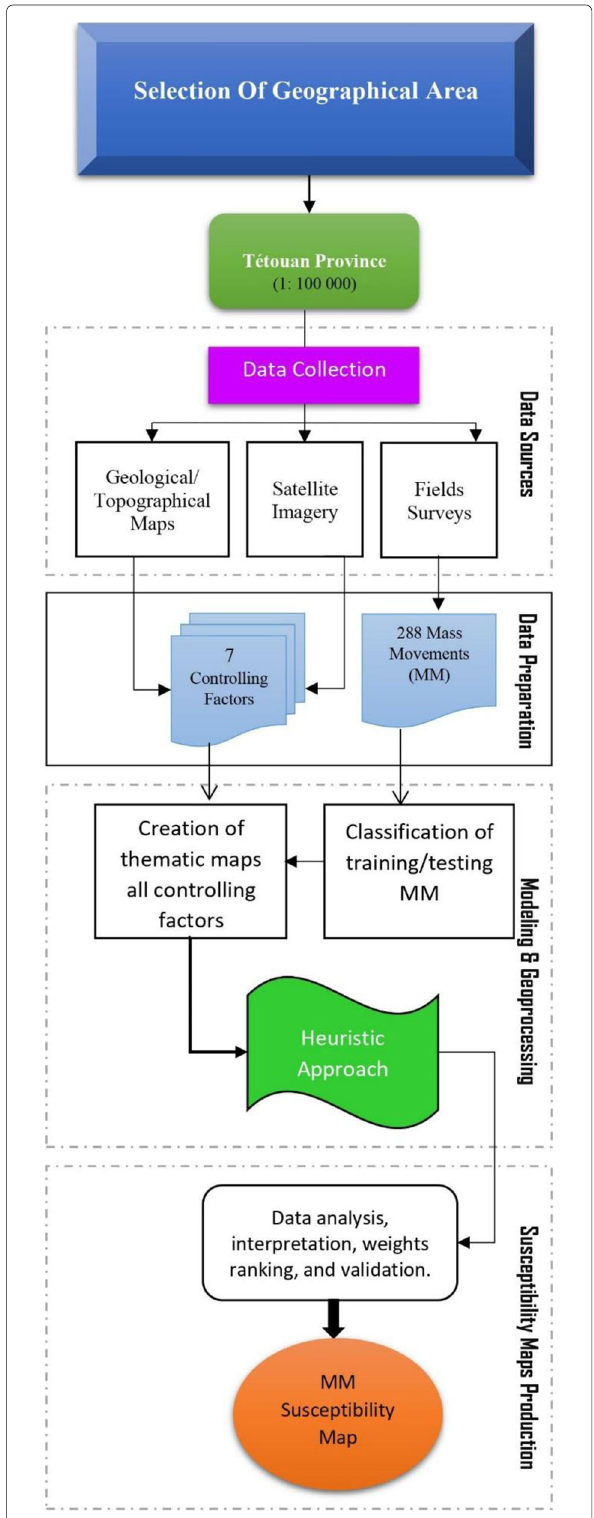
Fig. 3 Flowchart adopted to create the susceptibility map of MM by heuristic approach in Tétouan